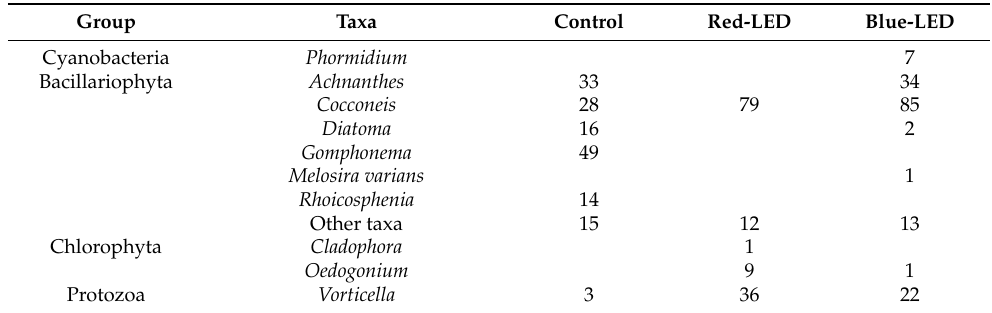
Figure A1. Changes in turbidity in the three depressions in ponds during the experiment. Daily mean ( ± 1 SD) is shown. Table A1. Cell abundance (cells mm − 2 ) of algal and microfauna on the filament of device in the three depressions at the end of experiment.